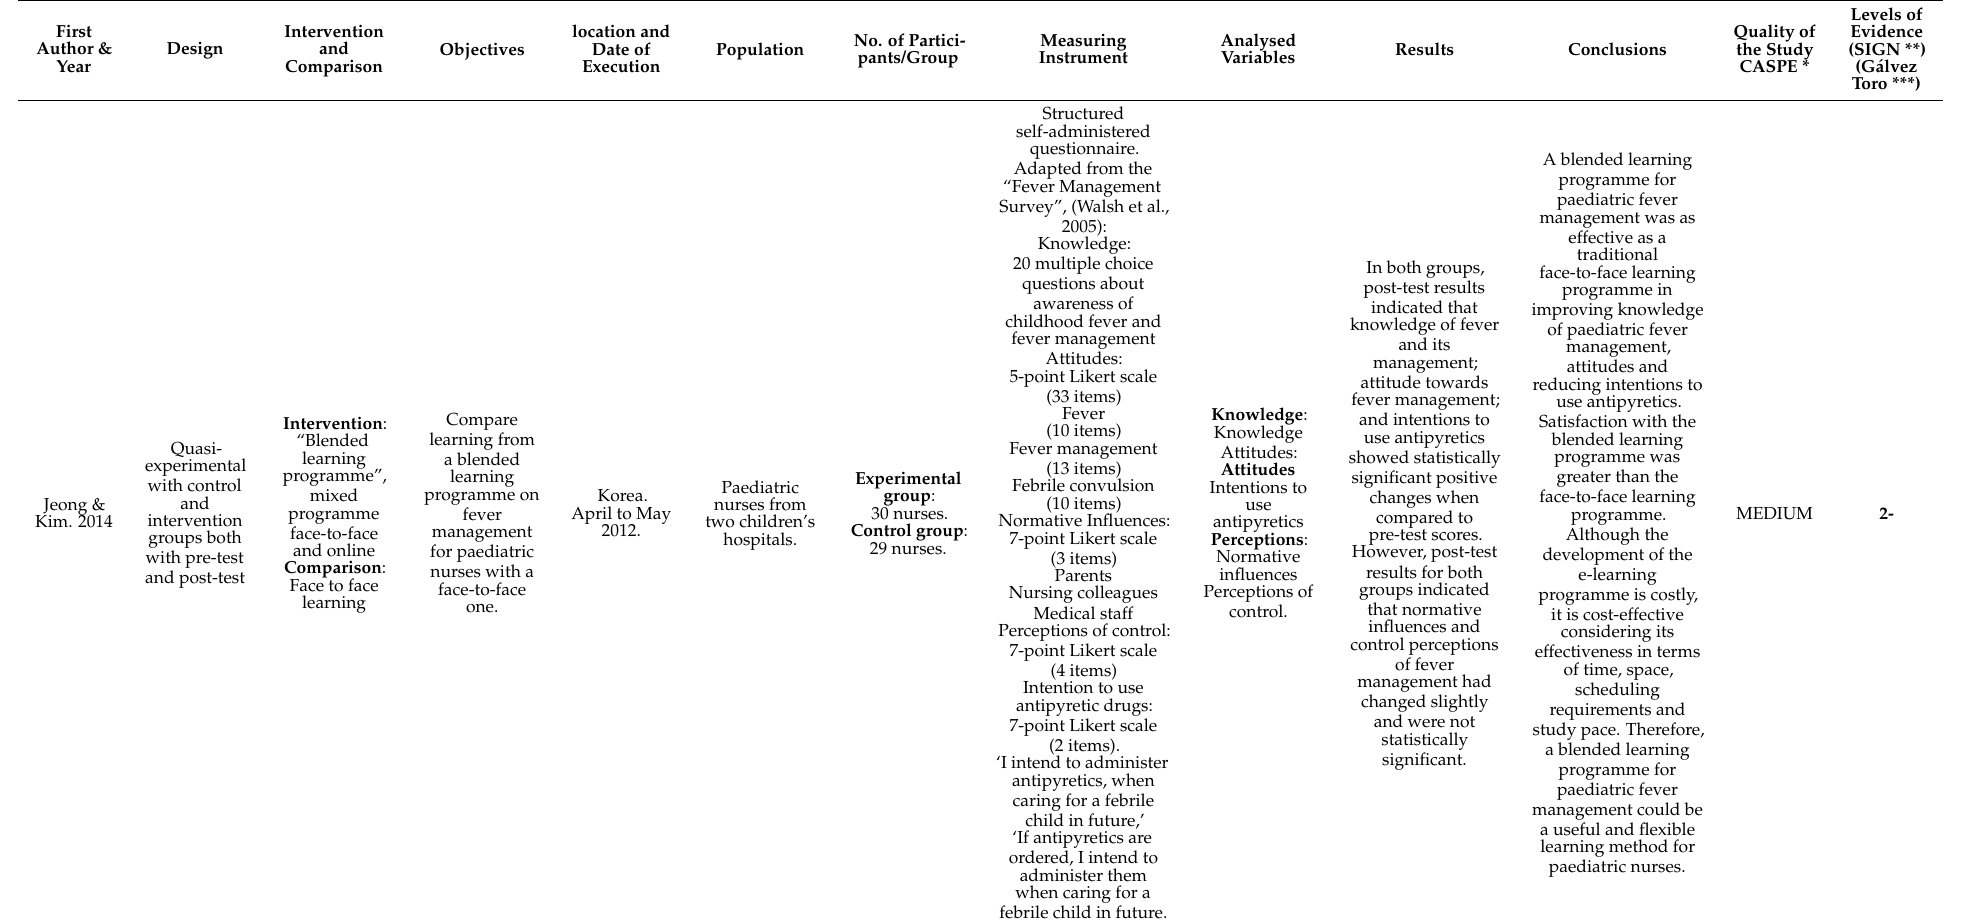
Table 2. Quality of studies measured by “Critical Appraisal Skills Programme España” (CASPe) *. Levels of evidence used: “Scottish Intercollegiate Guidelines Network” SIGN